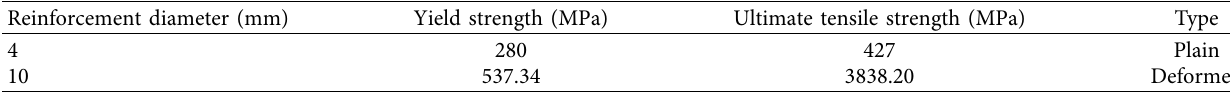
Figure 1: Arrangement of slab reinforcement (dimensions in mm) [33]. Table 1: Features of the steel materials [33].